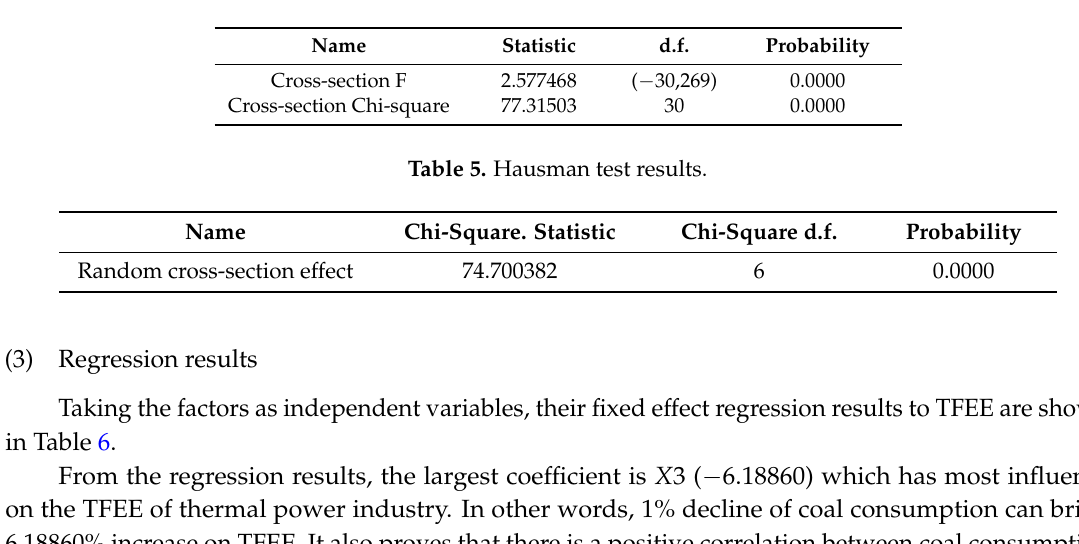
Table 4. F-Statistic test results.